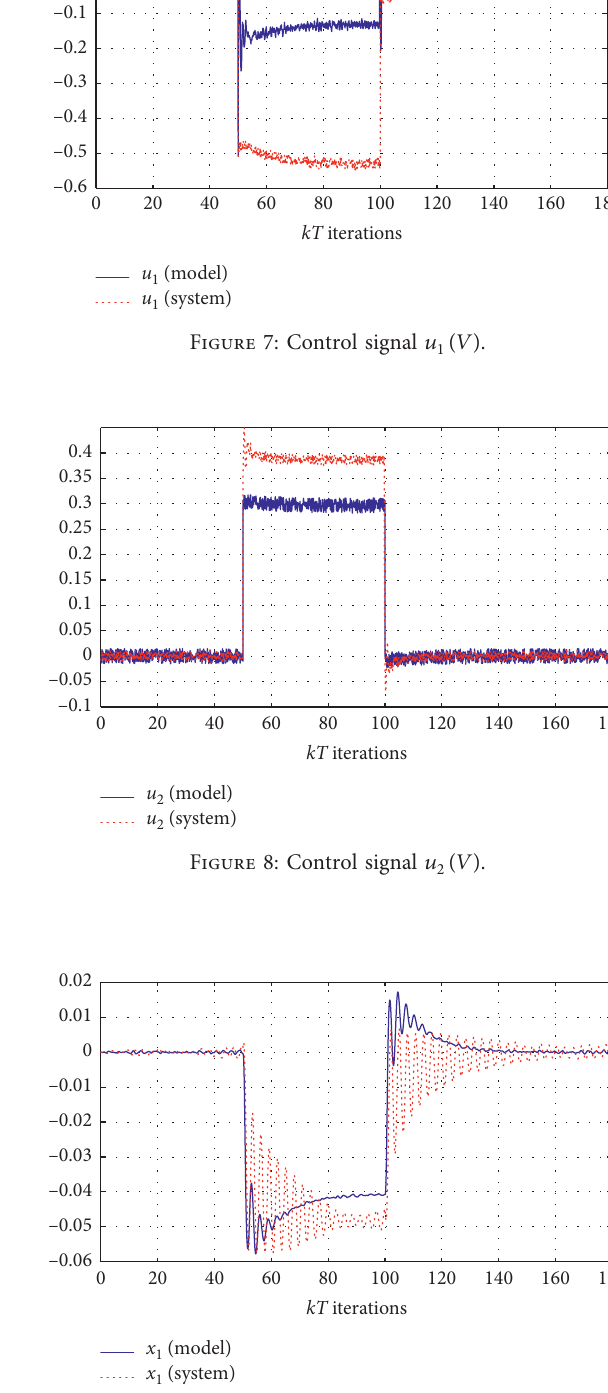
Figure 9: Response of the pitch angle of the closed-loop